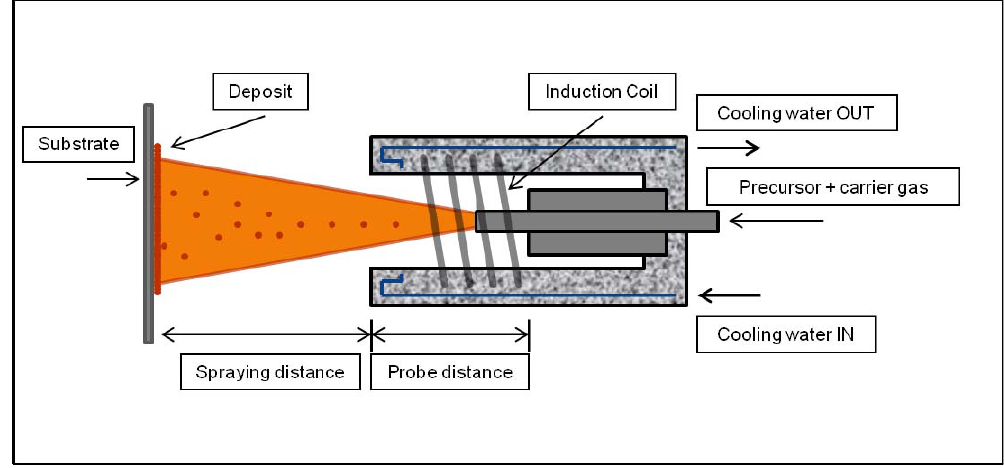
Figure 1. Schematic representation of a Radio Frequency (RF) plasma torch.